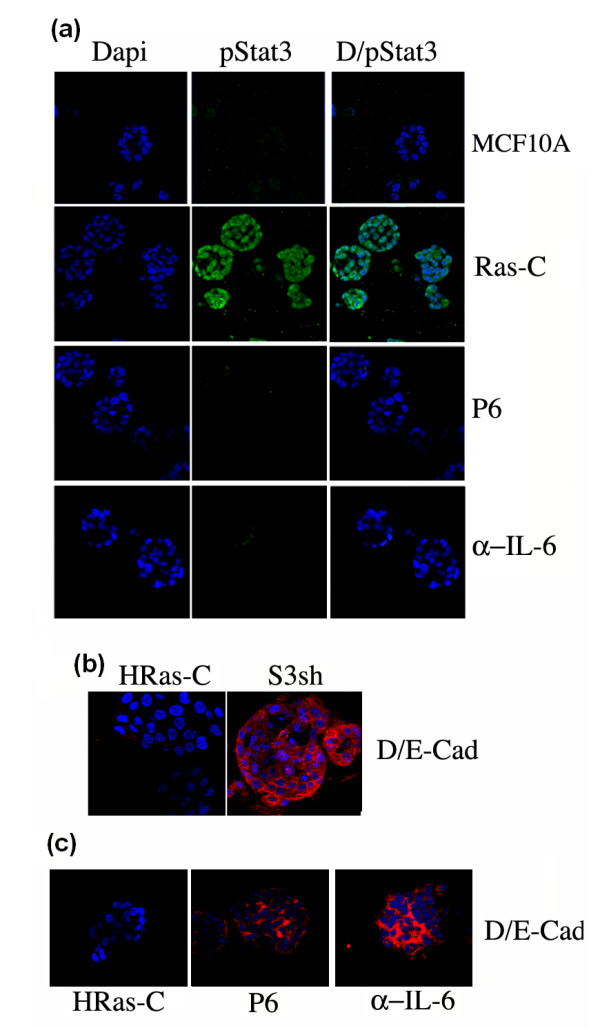
3-D morphogenic assays of MCF10A-Ras cells display IL-6/Jak/pStat3 signaling which regulate E-Cadherin levels. (a) MCF10A cells were grown in Matrigel as were MCF10A-Ras cells which were stained for pStat3 and Dapi by immunofluorescence treated with DMSO control (Ras-C), P6 (a pan-Jak inhibitor) or a blocking antibody to IL-6 (α-IL-6). (b) MCF10A-Ras cells expressing control (HRas-C) or Stat3 shRNA (S3sh) were grown in Matrigel and stained with Dapi and E-Cadherin (D/E-Cad) by immunofluorescence. (c) MCF10A-Ras cells were grown in matrigel and treated with DMSO (HRas-C), P6 or a blocking antibody to IL-6 (α-IL-6) and stained for Dapi and E-Cadherin (D/E-Cad).